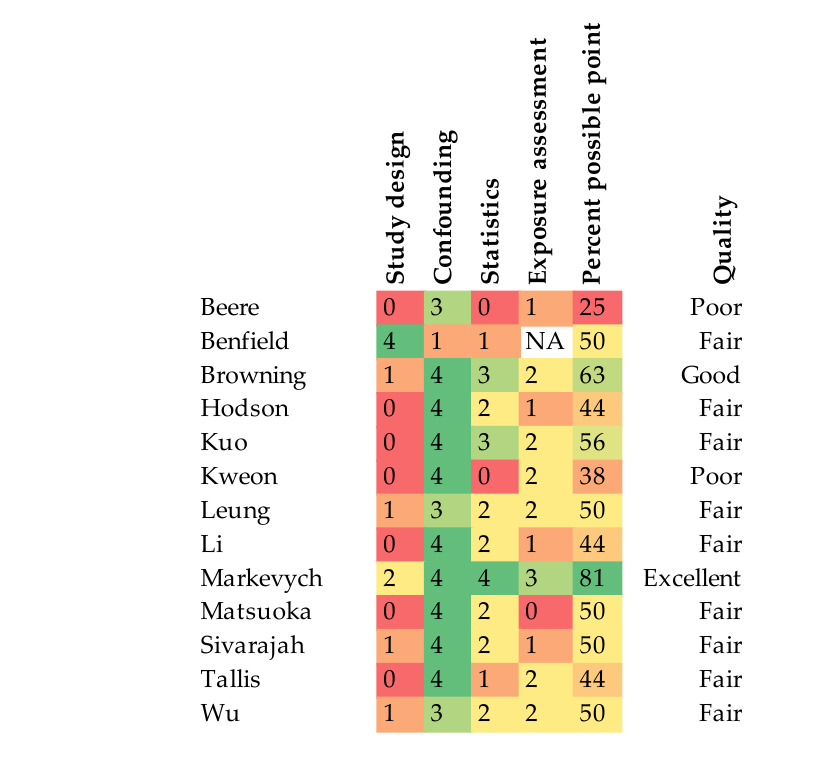
Figure A1. Points assigned to bias categories for articles in the review.